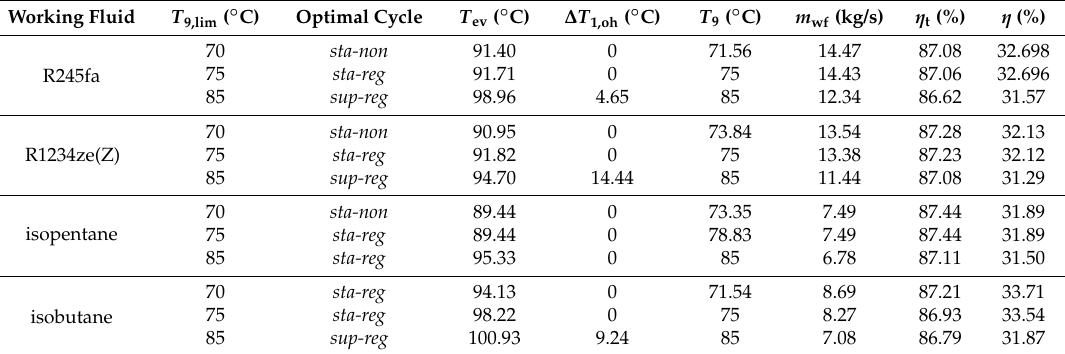
Table 5. Optimal cycle configuration and performances ( m hf = 10kg/s, T 8 = 150 ◦ C). Working Fluid T 9,lim ( ◦